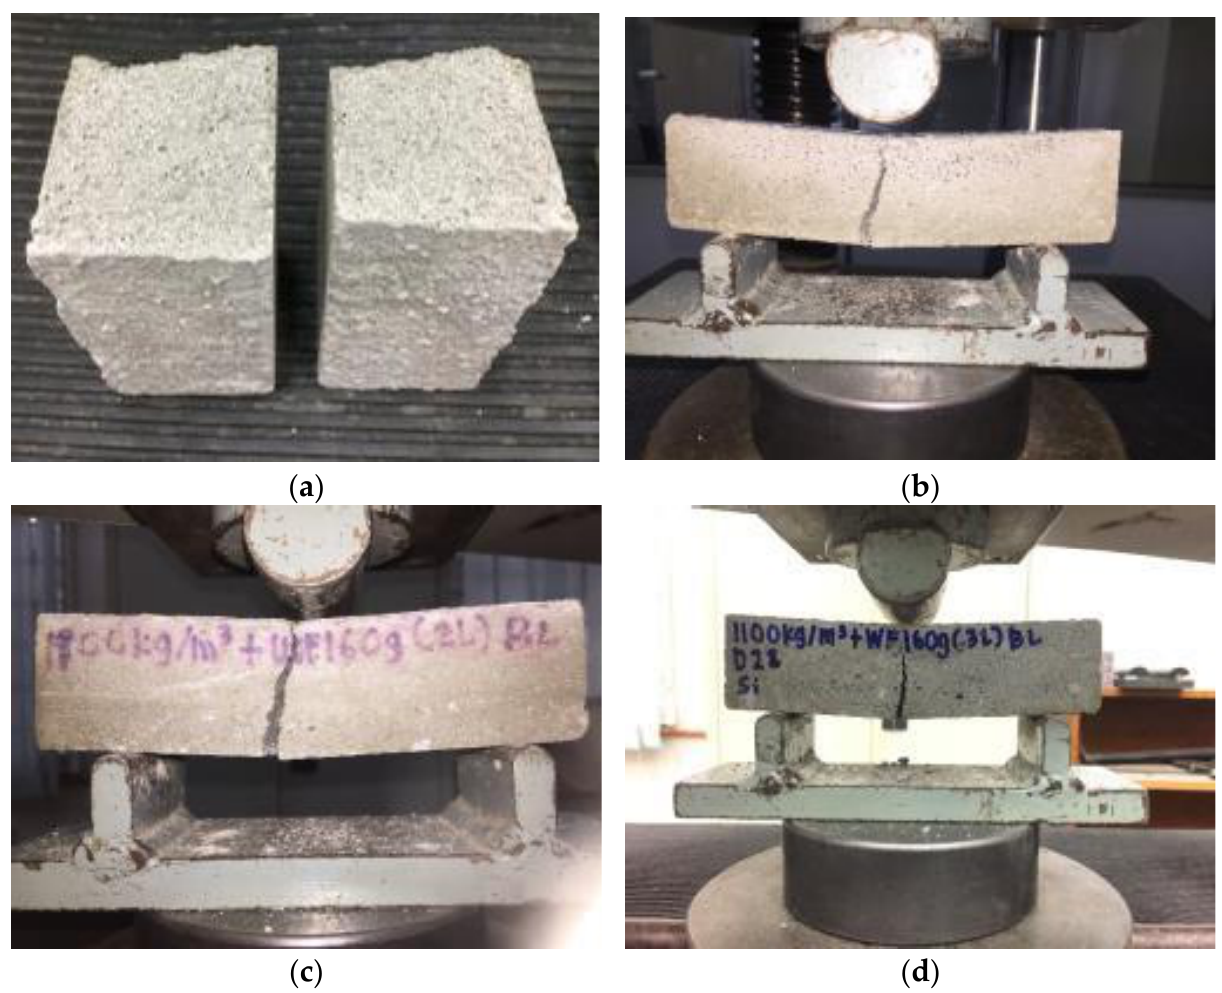
Figure 11. Failure modes of foamcrete under a flexural load. ( a ) Control specimen ( b ) 1 layer of FM ( c ) 2 layers of FM ( d ) 3 layers of FM.